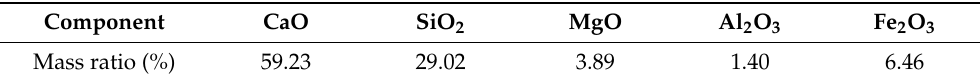
Table 2. Chemical composition of steel slag used in this